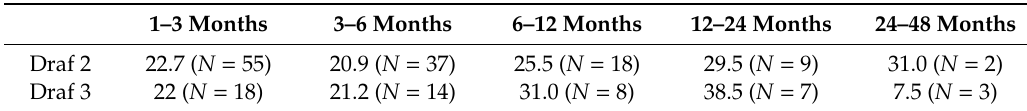
Table 4. Mean SNOT-22 scores evolution over time. Draf 2 / Draf